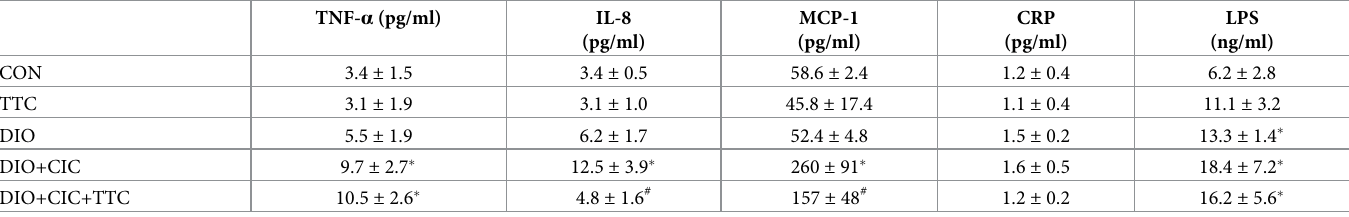
Table 2. Serum levels of proinflammatory cytokines, C-reactive protein, and lipopolysaccharide in Wistar rats at the end of the experiment. The results show mean values ±